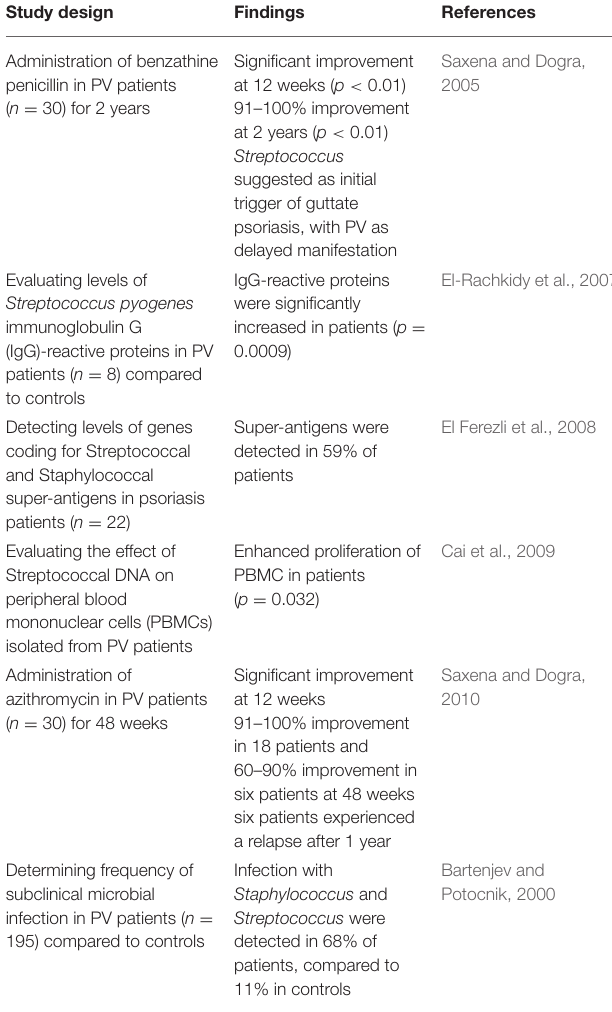
TABLE 1 | A summary of the most prominent findings that imply a bacterial component in